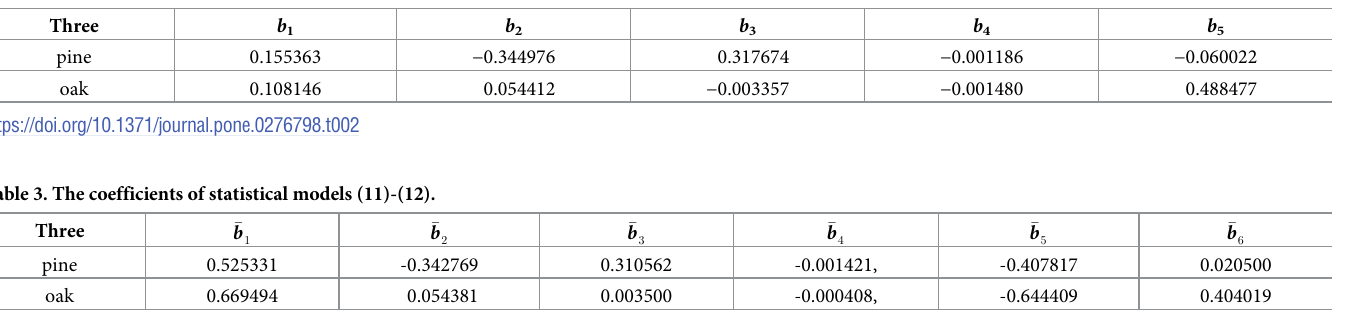
Table 2. The coefficients of statistical models (9)-(10).